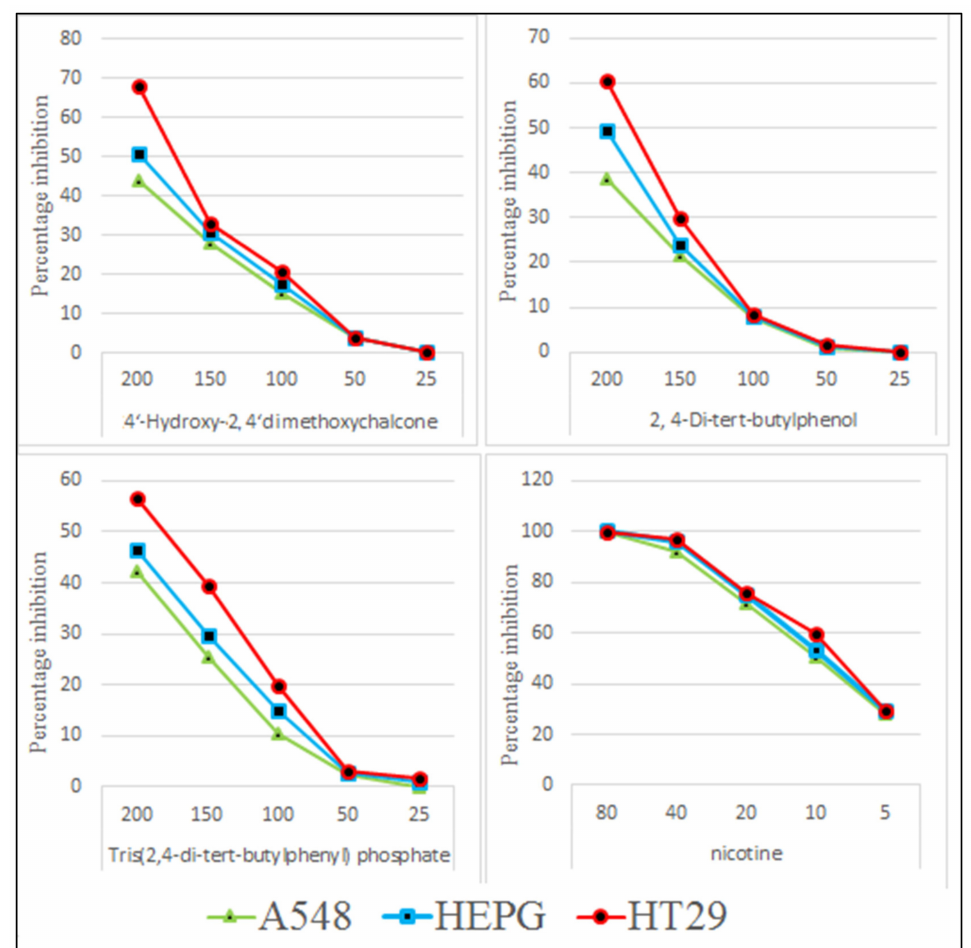
Figure 11. Cytotoxic potential of TDTBP: Tris (2,4-di- tert -butylphenyl), HDC: 2 (4-Hydroxy-2,4 (cid:48) - dimethoxychalcone), and DTBP 3 (2,4-di- tert -butylphenol).